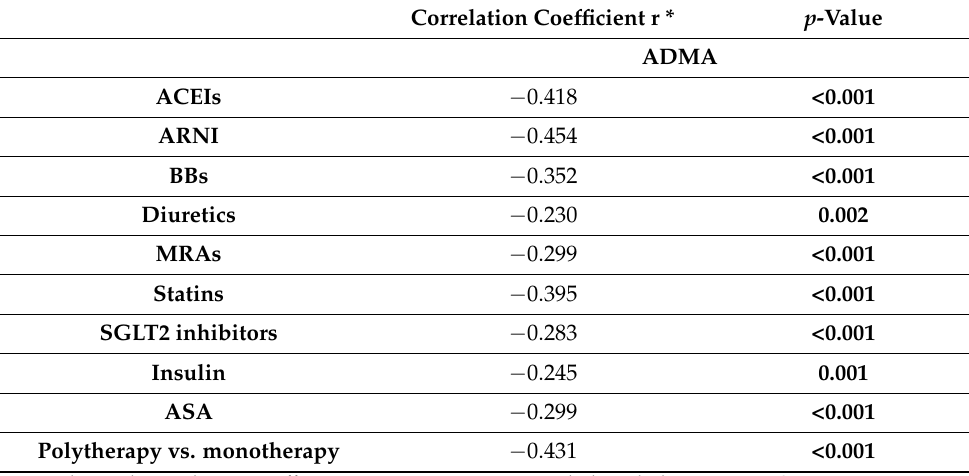
Table 6. Correlation between ADMA and certain groups of drugs. Correlation Coefficient r